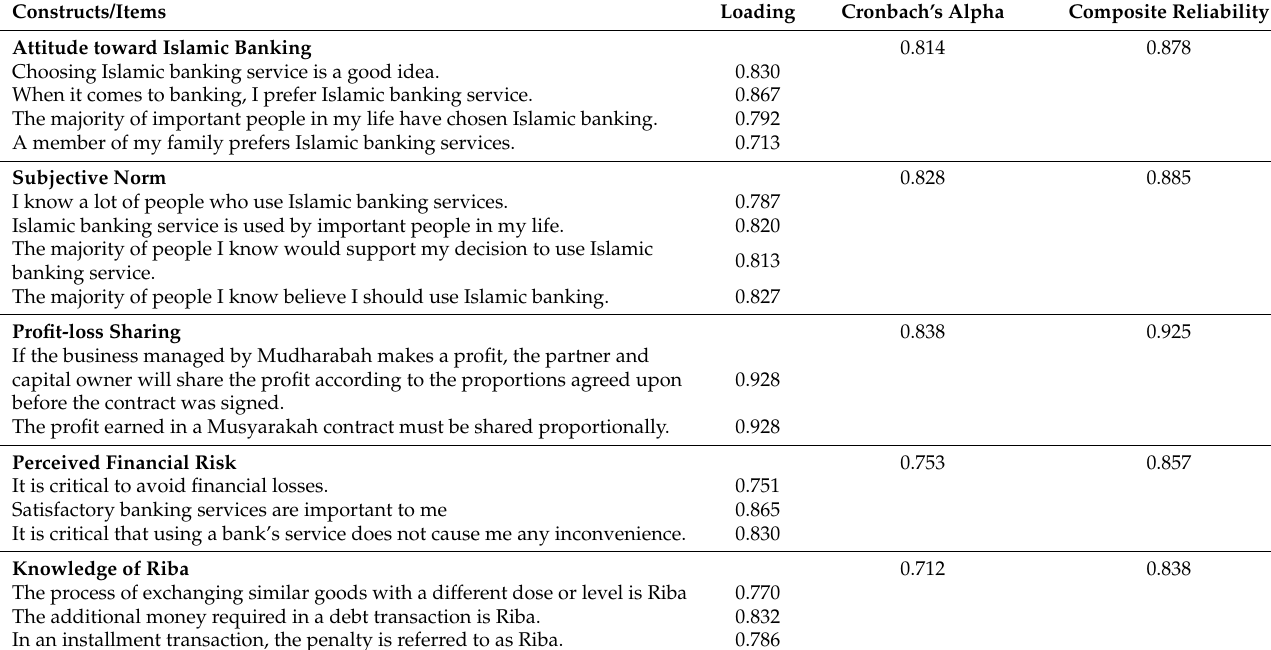
Table 2. Findings of measurement